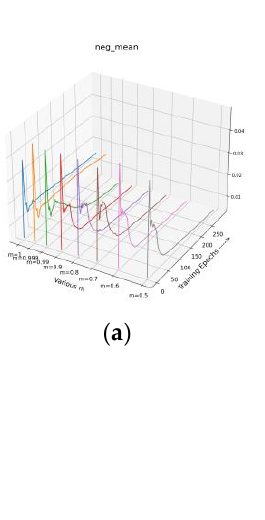
Figure 19. Similarity statistics of various 𝑚 in SCL training on the Houston dataset: ( a ) mean of negative similarity; ( b ) variance of negative similarity; ( c ) mean of positive similarity; ( d ) variance of positive similarity. Different colors corresponds to different values of 𝑚 .